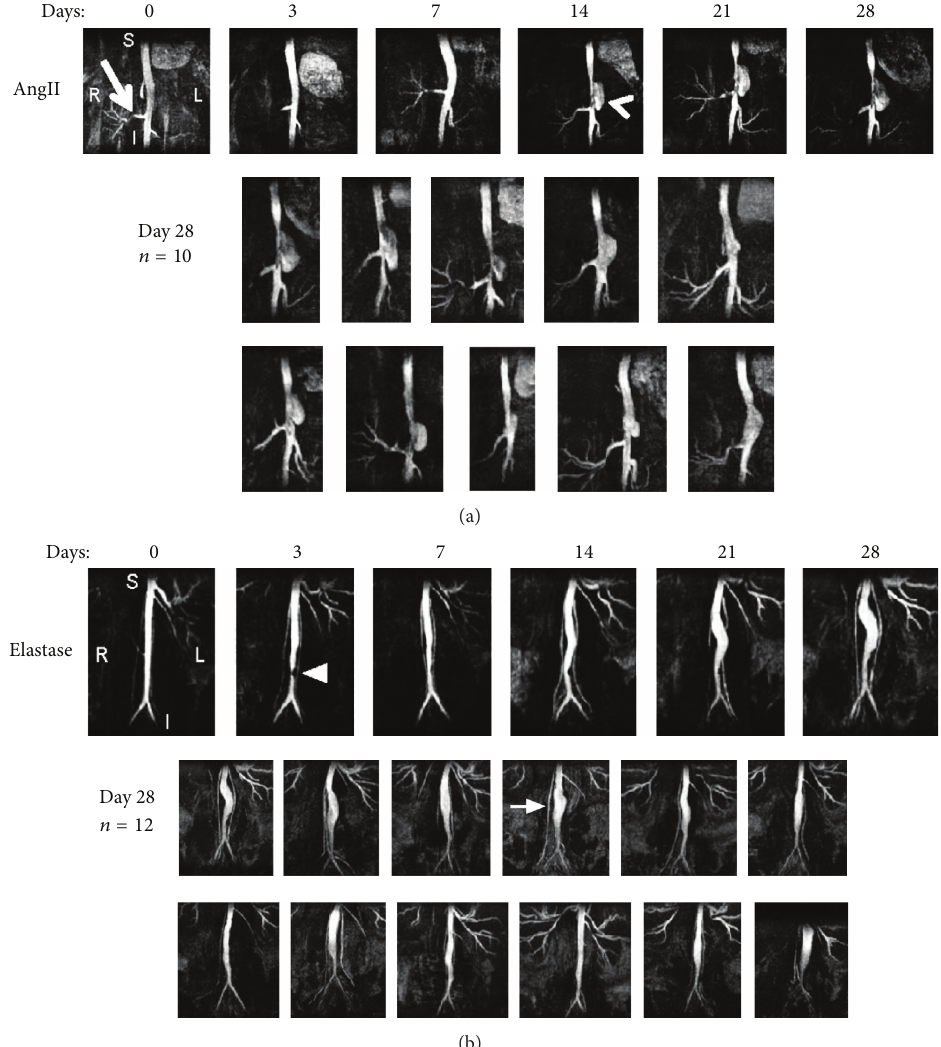
Figure 2: Coronal magnetic resonance maximum intensity projections showing lumen expansion in (a) angiotensin II-induced (AngII) and (b) elastase-induced abdominal aortic aneurysms (AAA). Angiotensin II-induced AAAs appear suddenly (arrowhead) and expand leftward directly above the right renal artery (arrow). Ten additional angiotensin II AAAs are shown at day 28. Elastase-induced AAAs expand slowly. Small region of signal hypointensity is seen at day 3 (triangle) due to a suture in the vessel. Twelve additional elastase AAAs are shown at day 28. The testicular artery is highlighted (arrow). Figure adapted from